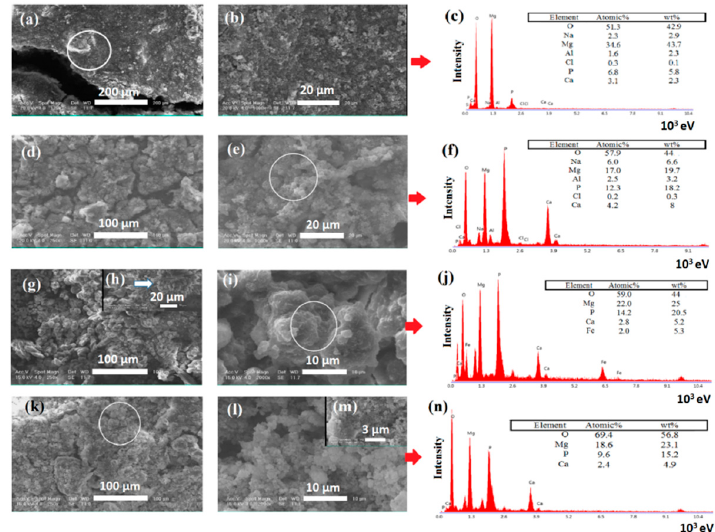
Figure 4. SEM images of ( a , b ) MAO, ( d , e ) MAO/P, ( g – i ) MAO/P/3B, ( k – m ) MAO/P/5B, and EDS spectra of ( c ) MAO, ( f ) MAO/P, ( j ) MAO/P/3B, and ( n ) MAO/P/5B after 28 days of immersion in SBF.